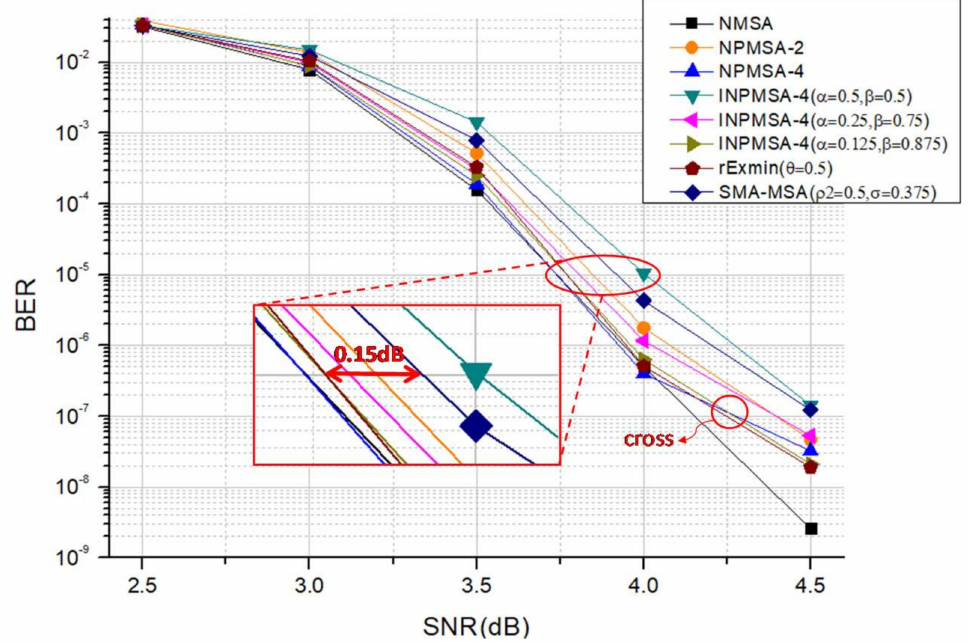
Figure 2. Simulation results of different algorithms in IEEE 802.11n.